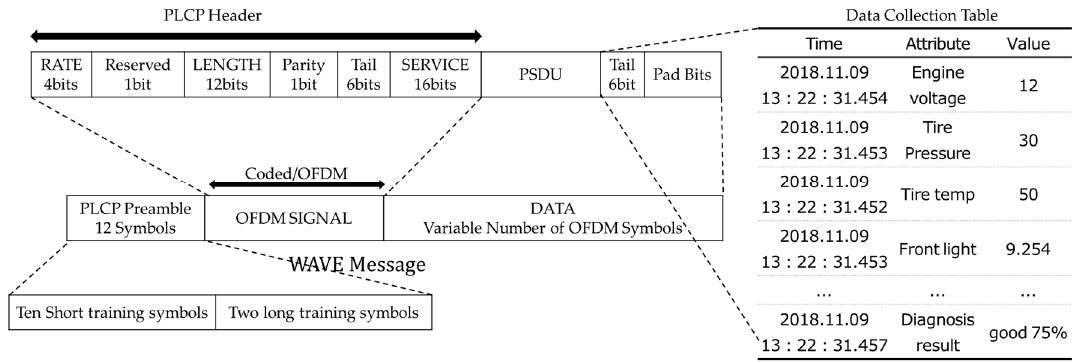
Figure 7. The generation of a WAVE message using the data collection table.